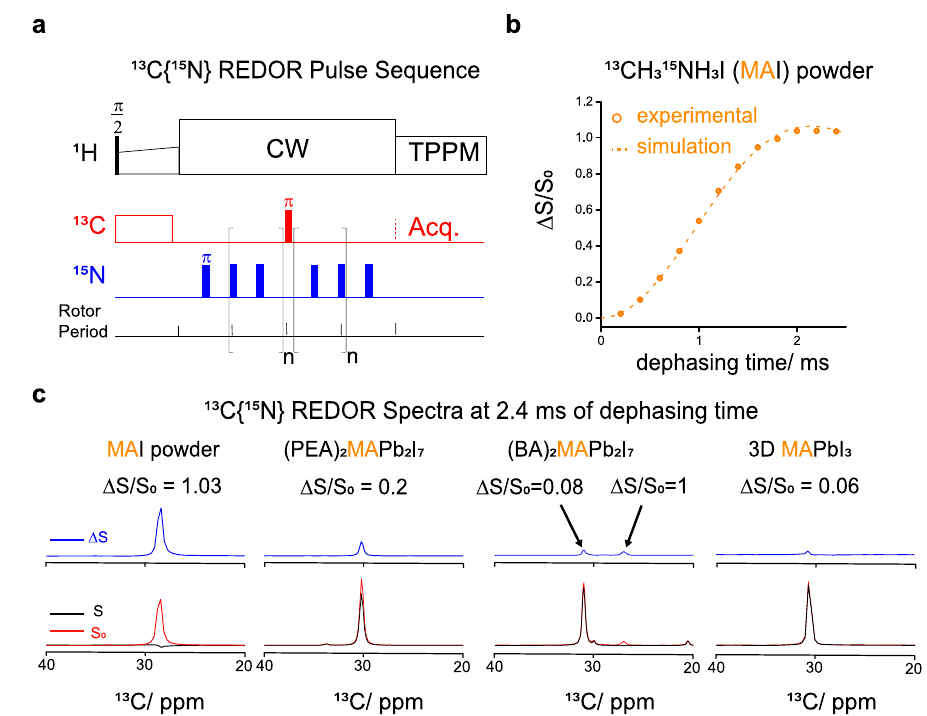
Fig. 2 13 C{ 15 N}REDOR NMR characterisation. a 13 C{ 15 N}REDOR NMR pulse sequence. b The experimental { 13 C} 15 N REDOR dephasing curve of the precursor 13 C, 15 N-MAI powder. The dashed line is the REDOR curves simulated using the length of carbon-nitrogen bond of MA molecule reported in X-ray crystallography research 33, 48 – 51 . c The { 13 C} 15 N REDOR spectra at the 2.4 ms dephasing time of 13 C, 15 N-MAI powder, 2D (PEA) 2 ( 13 C, 15 N-MA)Pb 2 I 7 ( n = 2), 2D (BA) 2 ( 13 C, 15 N-MA)Pb 2 I 7 ( n = 2) and 3D ( 13 C, 15 N-MA)PbI 3 .